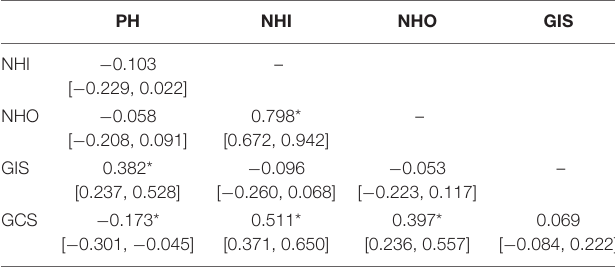
TABLE 7 | Latent variable correlations (sample